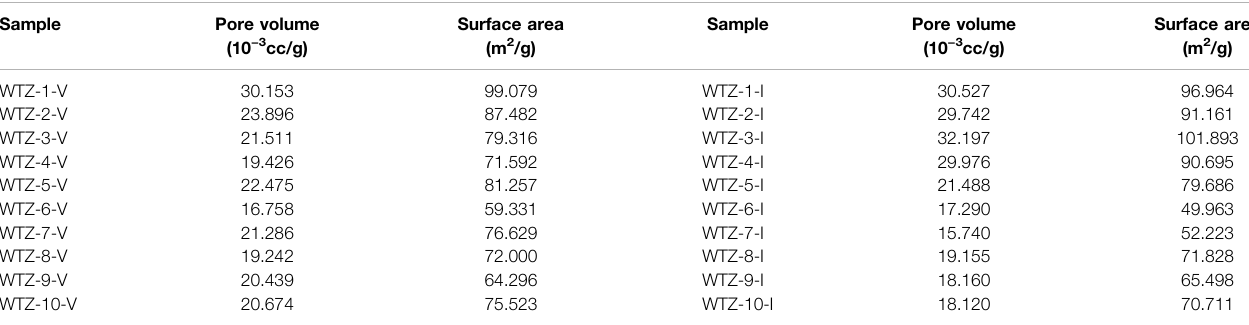
TABLE 2 | Results of CO 2 adsorption